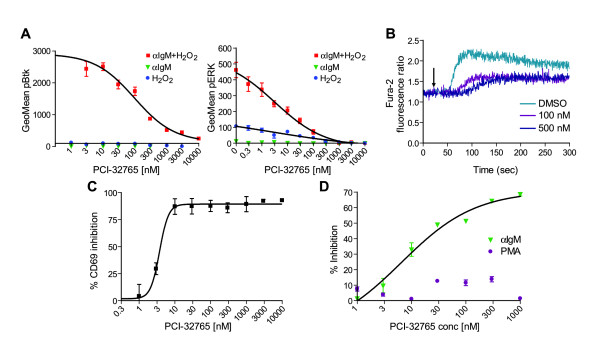
PCI-32765 potently inhibits anti-IgM stimulation of pBtk and pERK, calcium mobilization, early activation marker and anti-IgM induced cell proliferation in human primary B lymphocytes. (a) Inhibition of intracellular pBtk (Y551) and pERK1/2 staining in B cells following anti-IgM stimulation with flow cytometry methods. (b) Inhibition of calcium mobilization following B-cell antigen receptor (BCR) stimulation in primary B cells. (c) Inhibition of the early activation marker CD69 following BCR stimulation in primary B cells. (d) PCI-32765 inhibits B lymphocyte proliferation stimulated by anti-IgM but not phorbol myristate acetate. Anti-CD3/28 failed to stimulate purified human B lymphocytes (not shown).